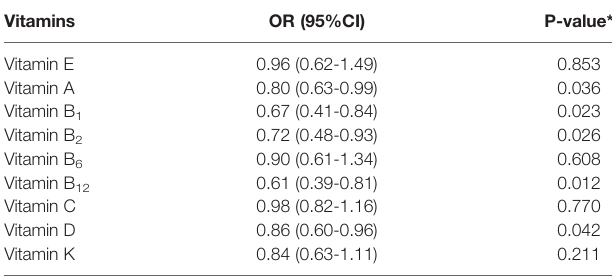
TABLE 1 | Baseline characteristics among 3634 participants in the NHANES 2013 – 2016.